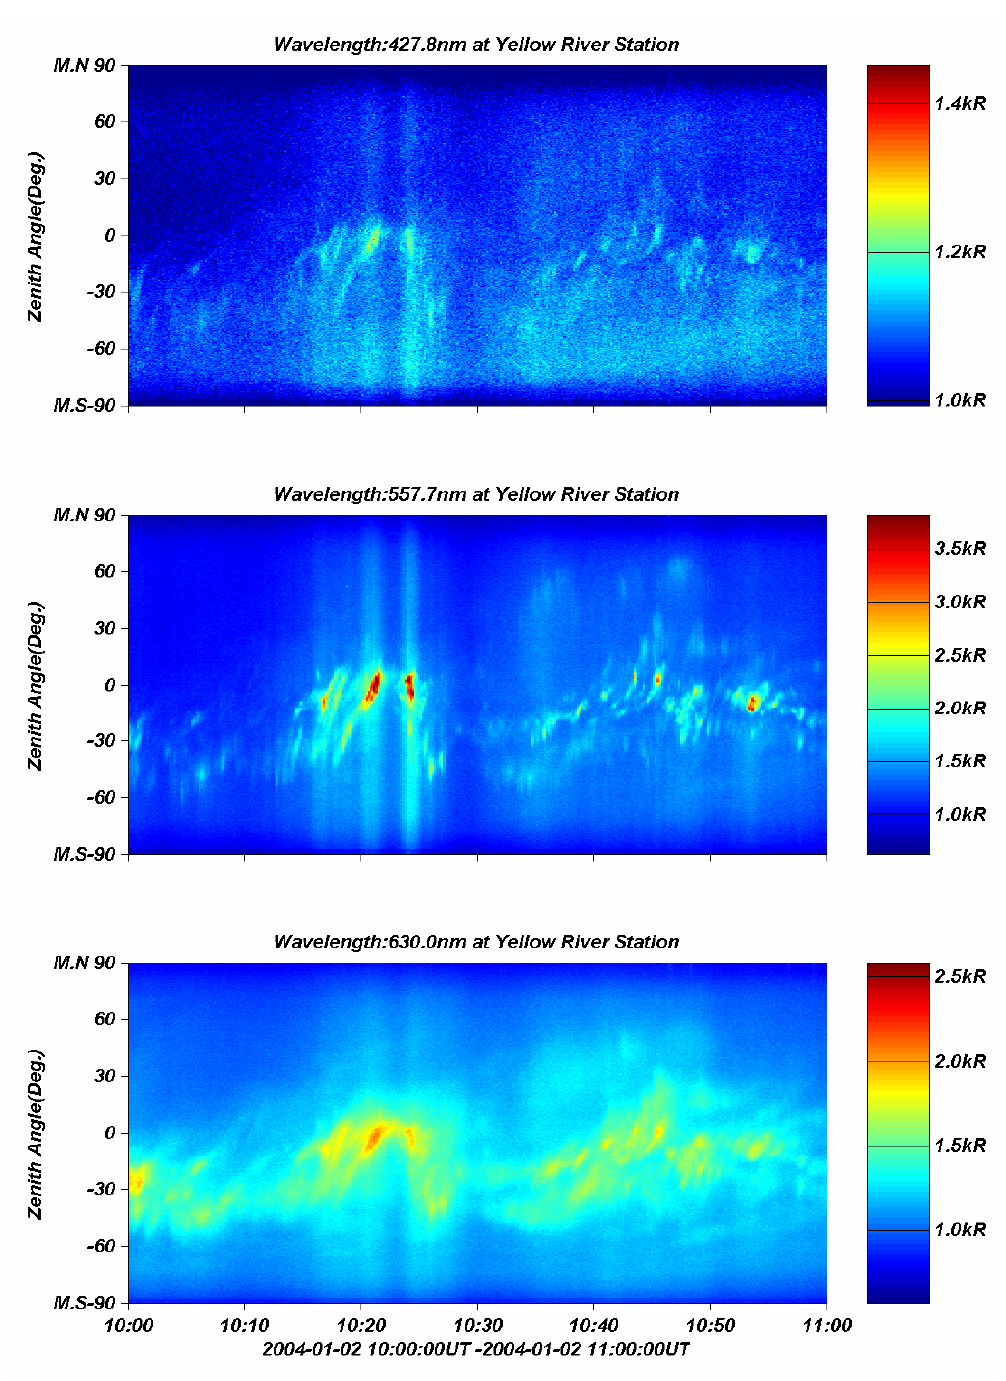
Fig. 4. The Keograms derived from 3 sets of CCD all-sky imagers at Yellow River Station in Ny- ˚Alesund during 10:00–11:00UT on 2 January Fig. 4 The Keograms derived from 3 sets of CCD all-sky imager at Yellow River Station in Ny-Ålesund during 10:00-11:00 UT on 2 January 2004.